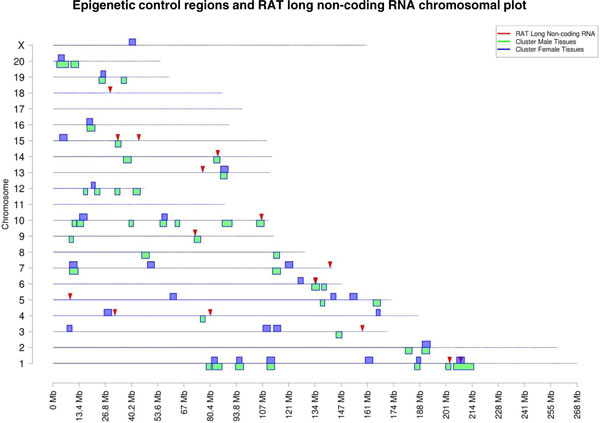
Chromosomal plot showing gene clustering in epigenetic control regions of male tissues and
female tissues overlapped with rat long non-coding RNA (arrowheads). Inset provides color
code.